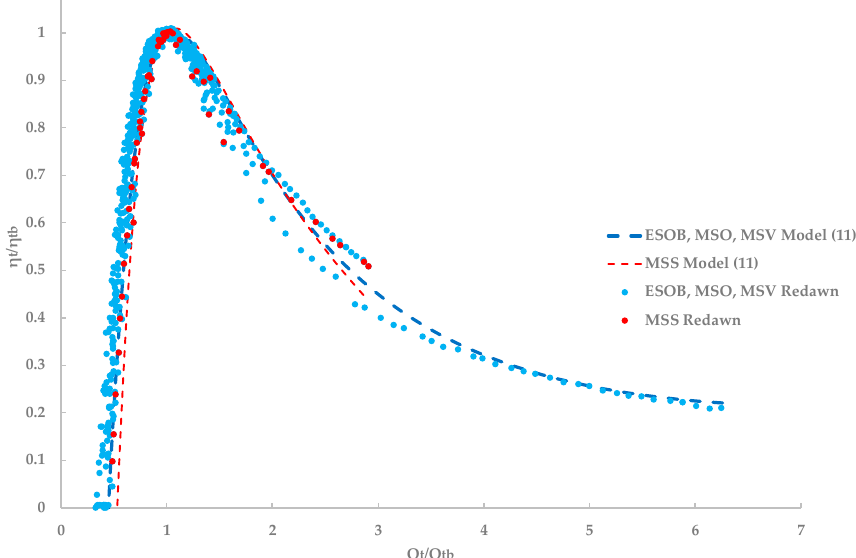
Figure 7. Comparison of Redawn database (ESOB, MSO, MSV, MSS) with efficiency-discharge evaluated using Relationship (11).